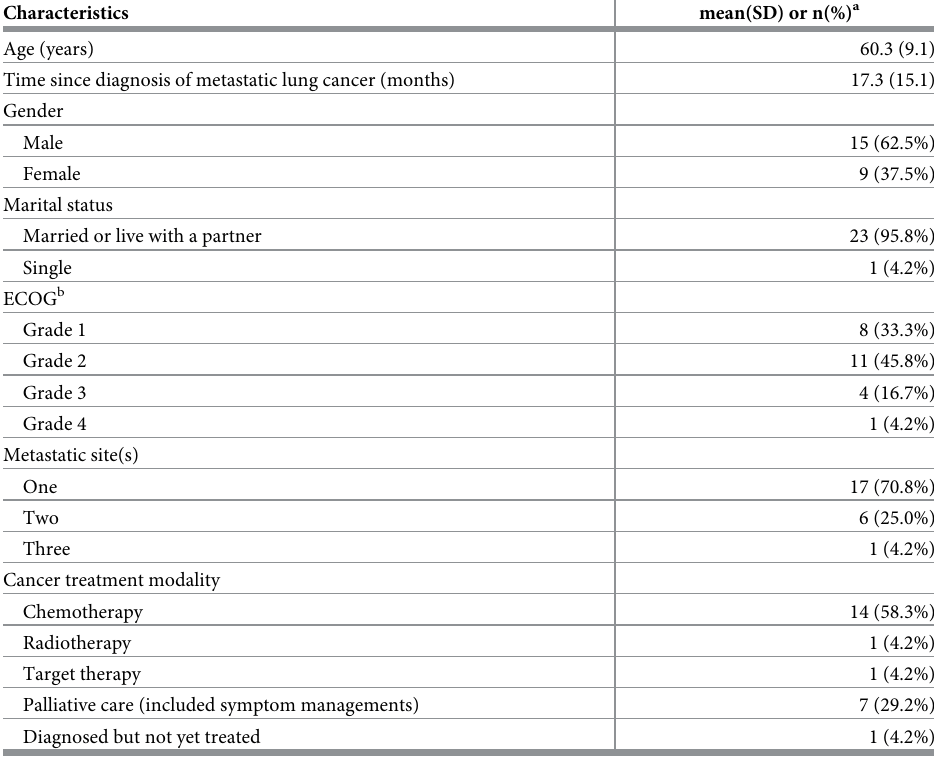
Table 2. Characteristics of participants with metastatic lung cancer ( N =